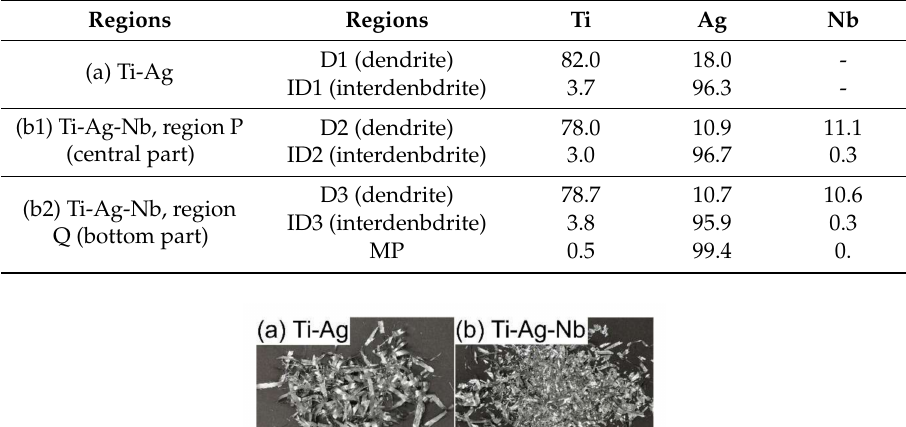
Table 2. EPMA-WDS analysis of arc-melted ingots of the Ti 53.4 Ag 33.3 Nb 13.3 alloy, together with the data of the binary Ti 66.7 Ag 33.3 alloy as a reference. The corresponding positions of the measured area